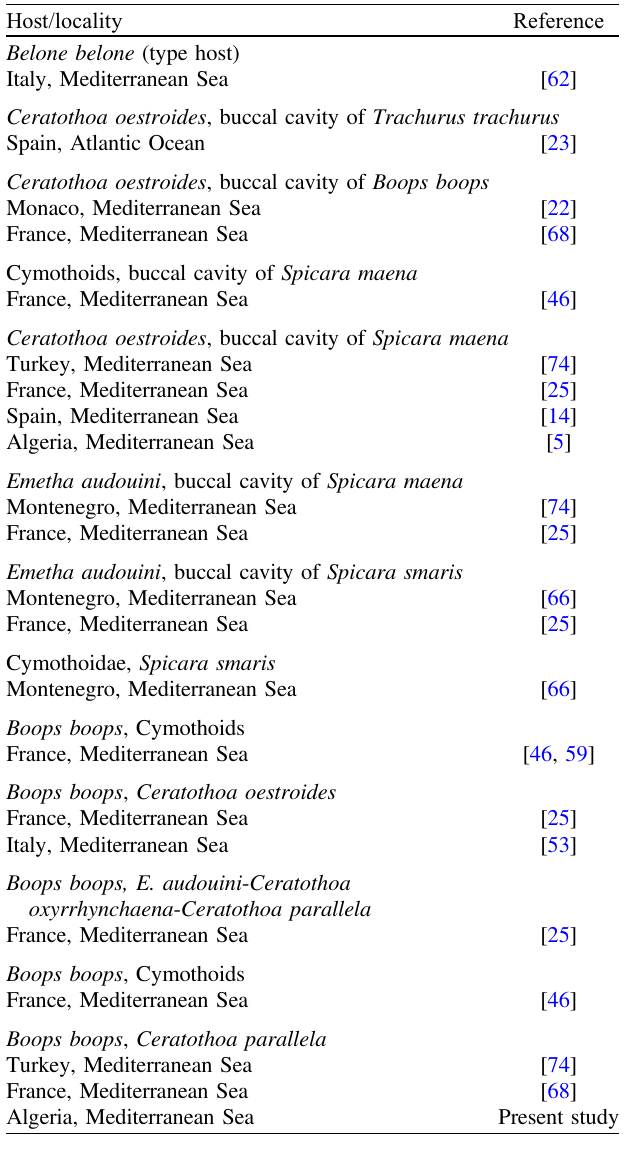
Table 1. Hosts and localities of Cyclocotyla bellones reported in the